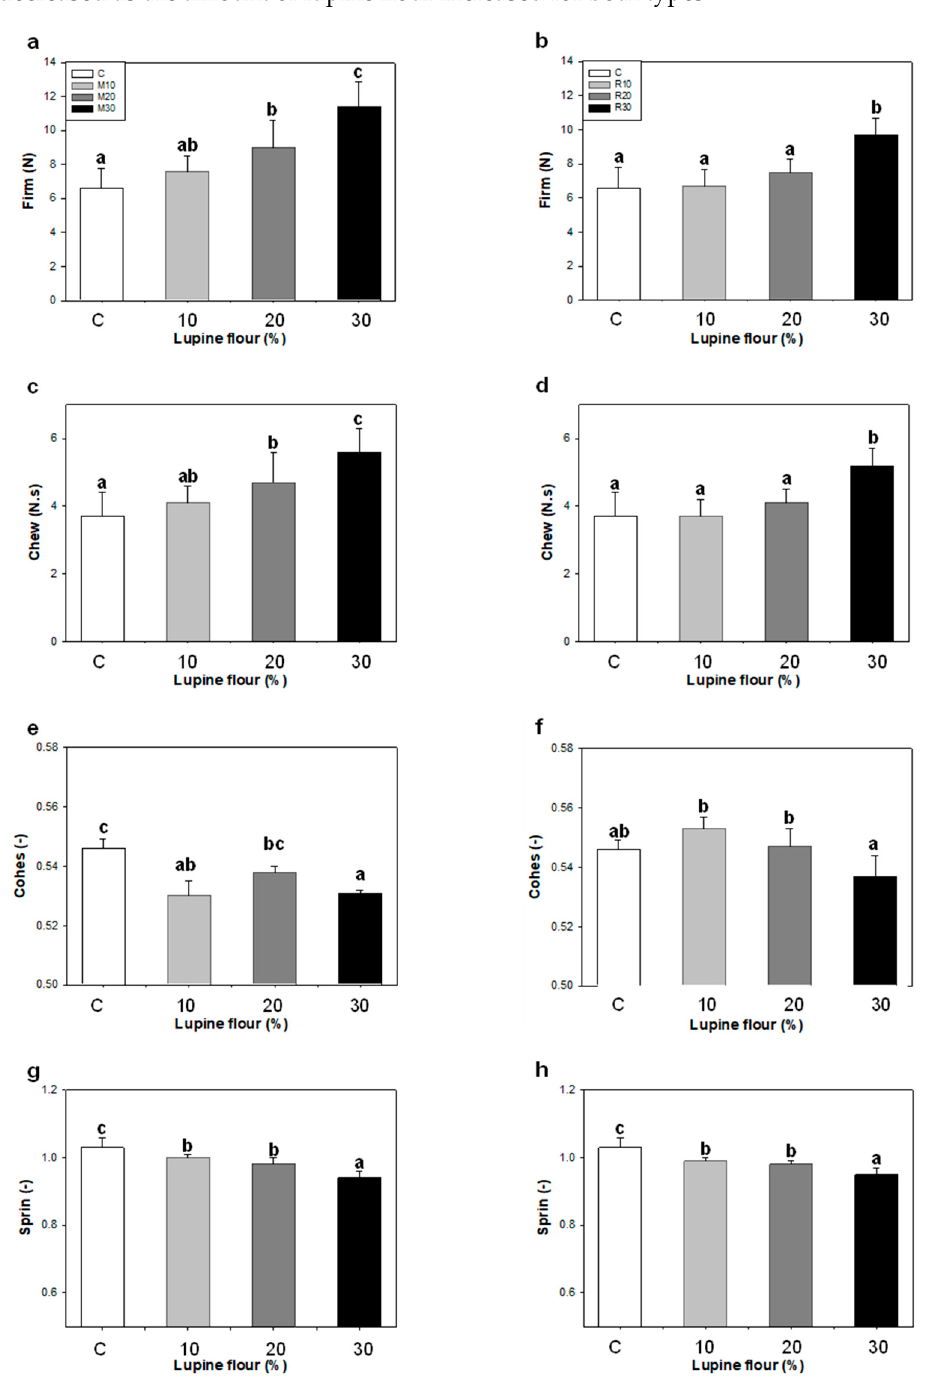
Figure 5. Texture parameters of bread crumbs with lupine flours: ( a , b ) Firm: firmness; ( c , d ) Chew: chewiness; ( e , f ) Cohes: cohesiveness; ( g , h ) Sprin: springiness or elasticity. Breads with Misak flour: ( a , c , e , g ). Breads with Rumbo flour: ( b , d , f , h ). Errors bars: standard deviations. Different letters indicate significant differences ( p < 0.05).